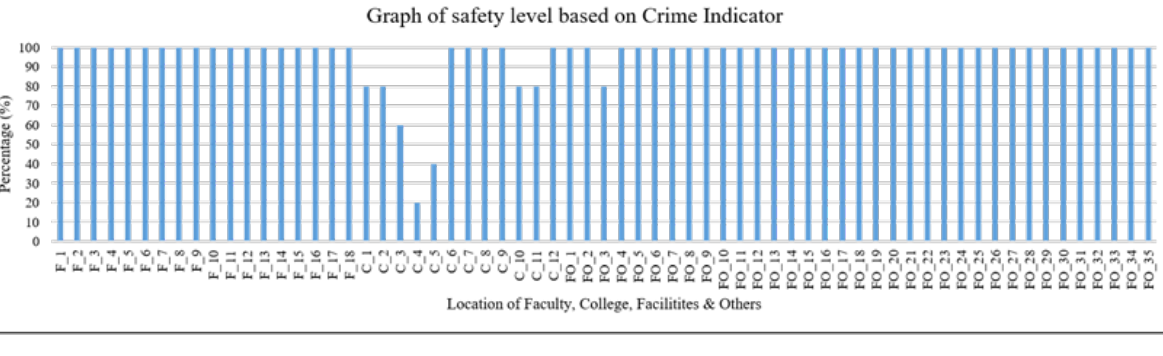
Figure 3. Results of Crime Indicator.